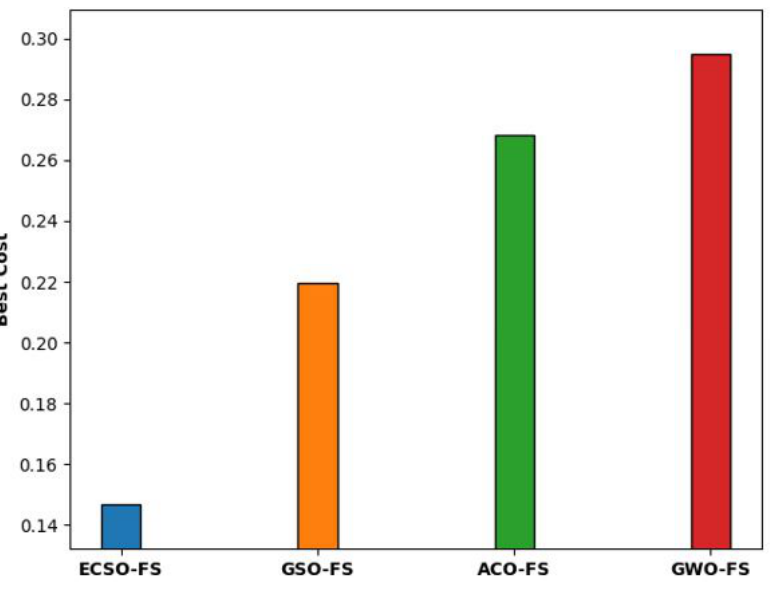
Figure 4. Best cost analysis of ESO-FS